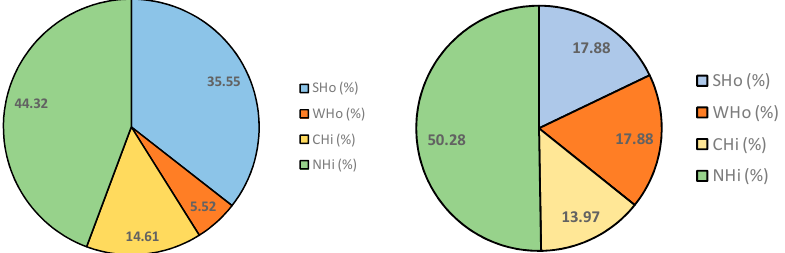
Figure 1. Organic matter type according to the fractionation experiments (S1 on the left and S2 on the right ).